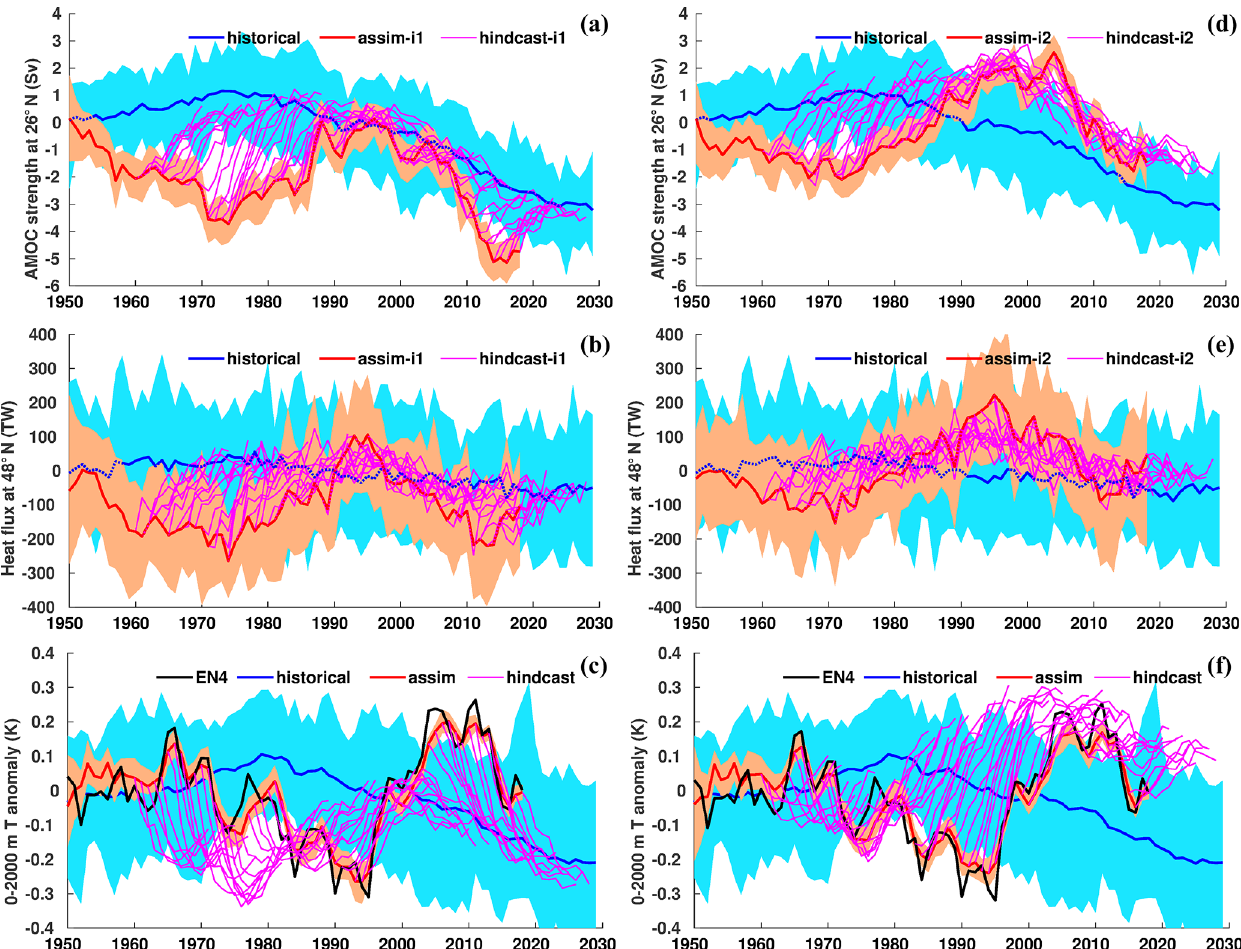
Figure 12. AMOC strength at 26 ◦ N, Atlantic meridional ocean heat transport at 48 ◦ N and 0–2000m temperature averaged over the SPNA box (48–65 ◦ N, 60–15 ◦ W) for i1 (a–c) and i2 (d–f) . Solid lines show ensemble means of historical (blue), assim (red) and hindcast (purple) experiments, with the 1950–2010 average of historical subtracted. Shading denotes ensemble minima and maxima.